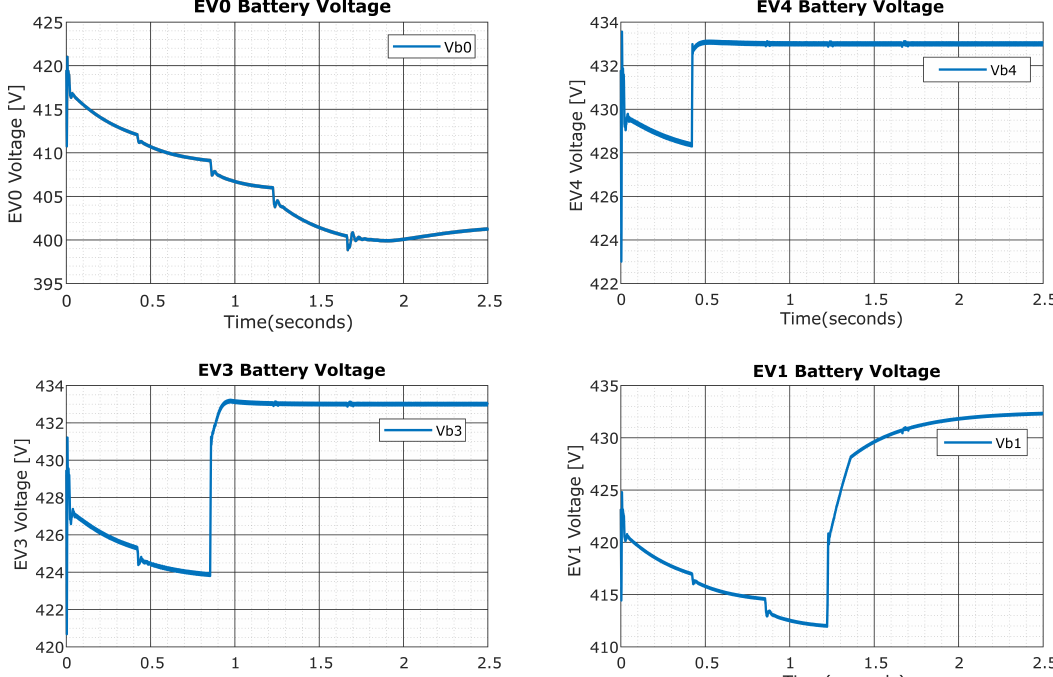
Figure 15. Battery voltage in both Mode 1 and Mode 2 [21], © 2021 IEEE.